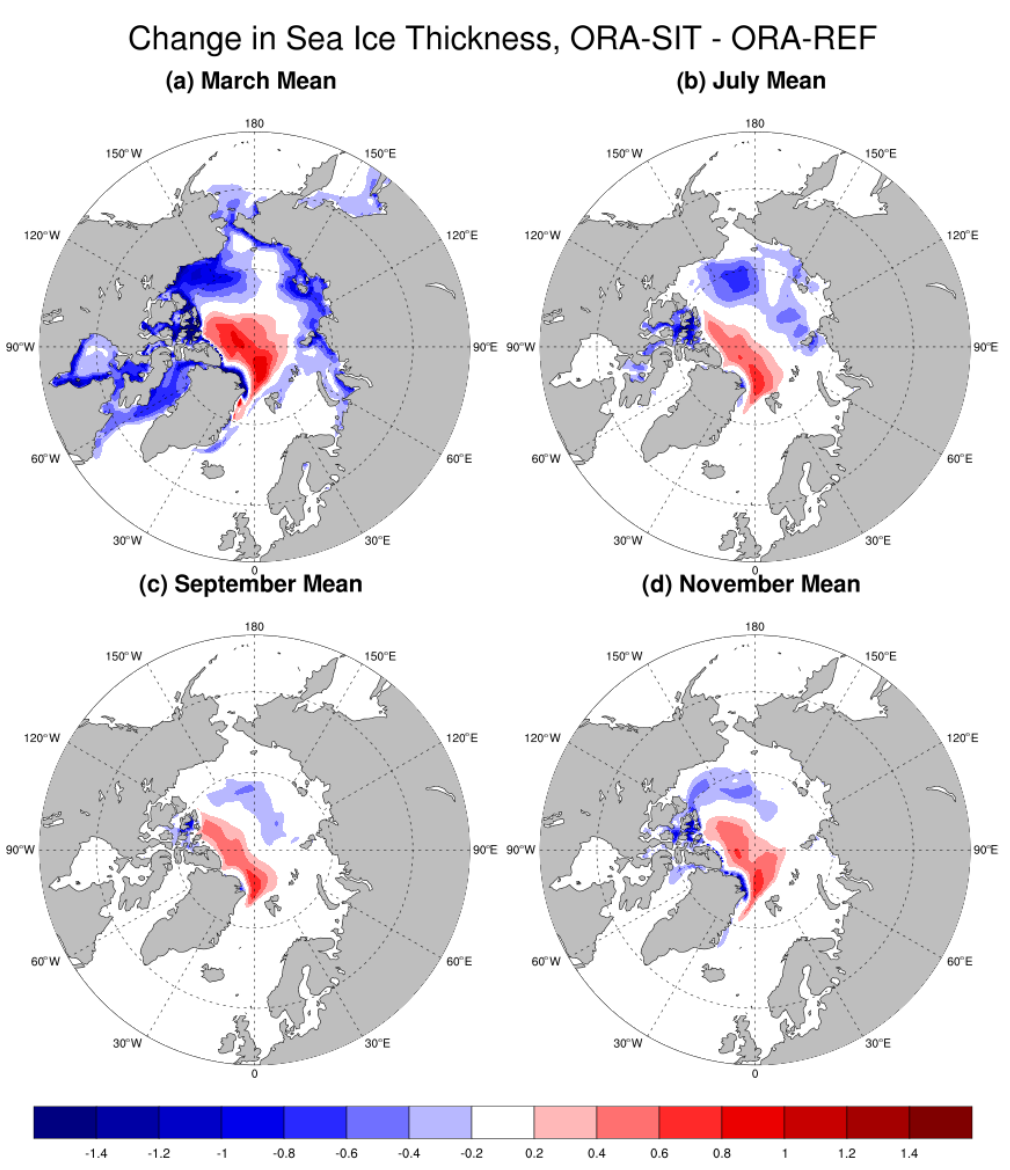
Figure 2. Difference in monthly-mean (2011–2016) sea ice thickness (m) between experiments ORA-SIT and ORA-REF for (a) March and (b) July and for (c) September and (d) November